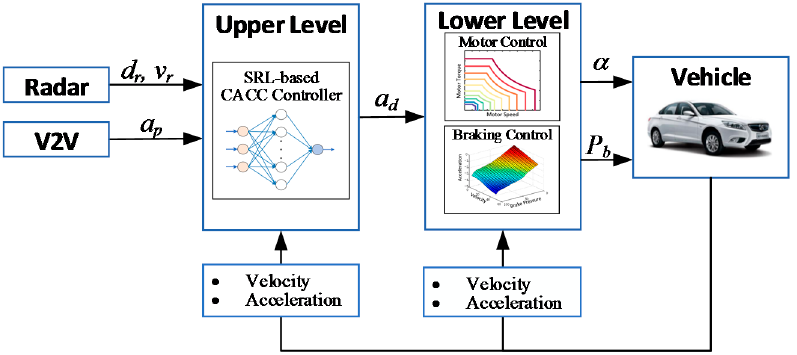
Figure 1. Control framework for the CACC system.